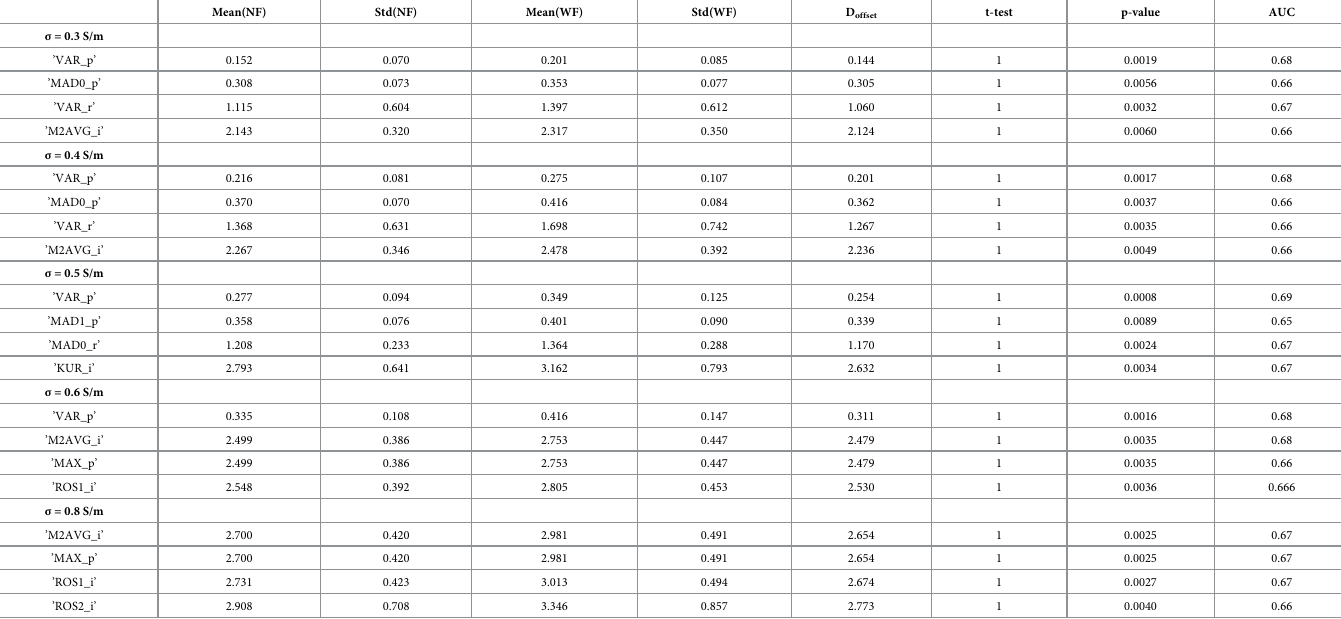
Table 4. List of the selected features for the selected conductivity weighed images.